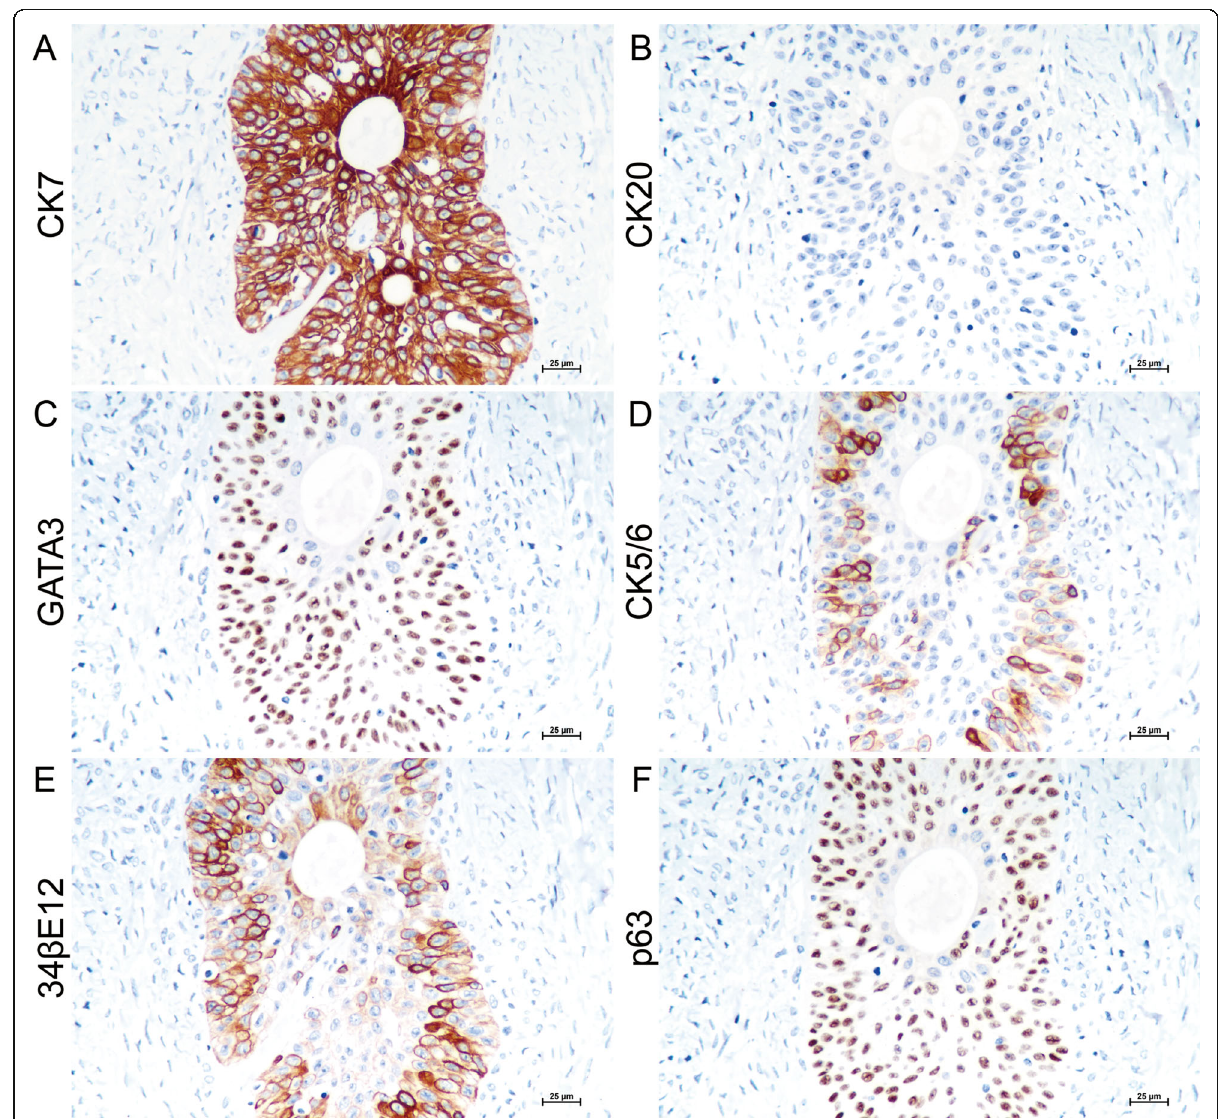
Fig. 3 Immunophenotype of EOBTs. Epithelial cells exhibited strong activity for CK7 ( a ), rather than CK20 ( b ). Nuclear positivity for GATA3 ( c ). The graded intensity of CK5/6 ( d ) and 34 β E12 staining ( e ) in cell nests. P63 decorated the majority of the epithelium ( f ). Original magnification x